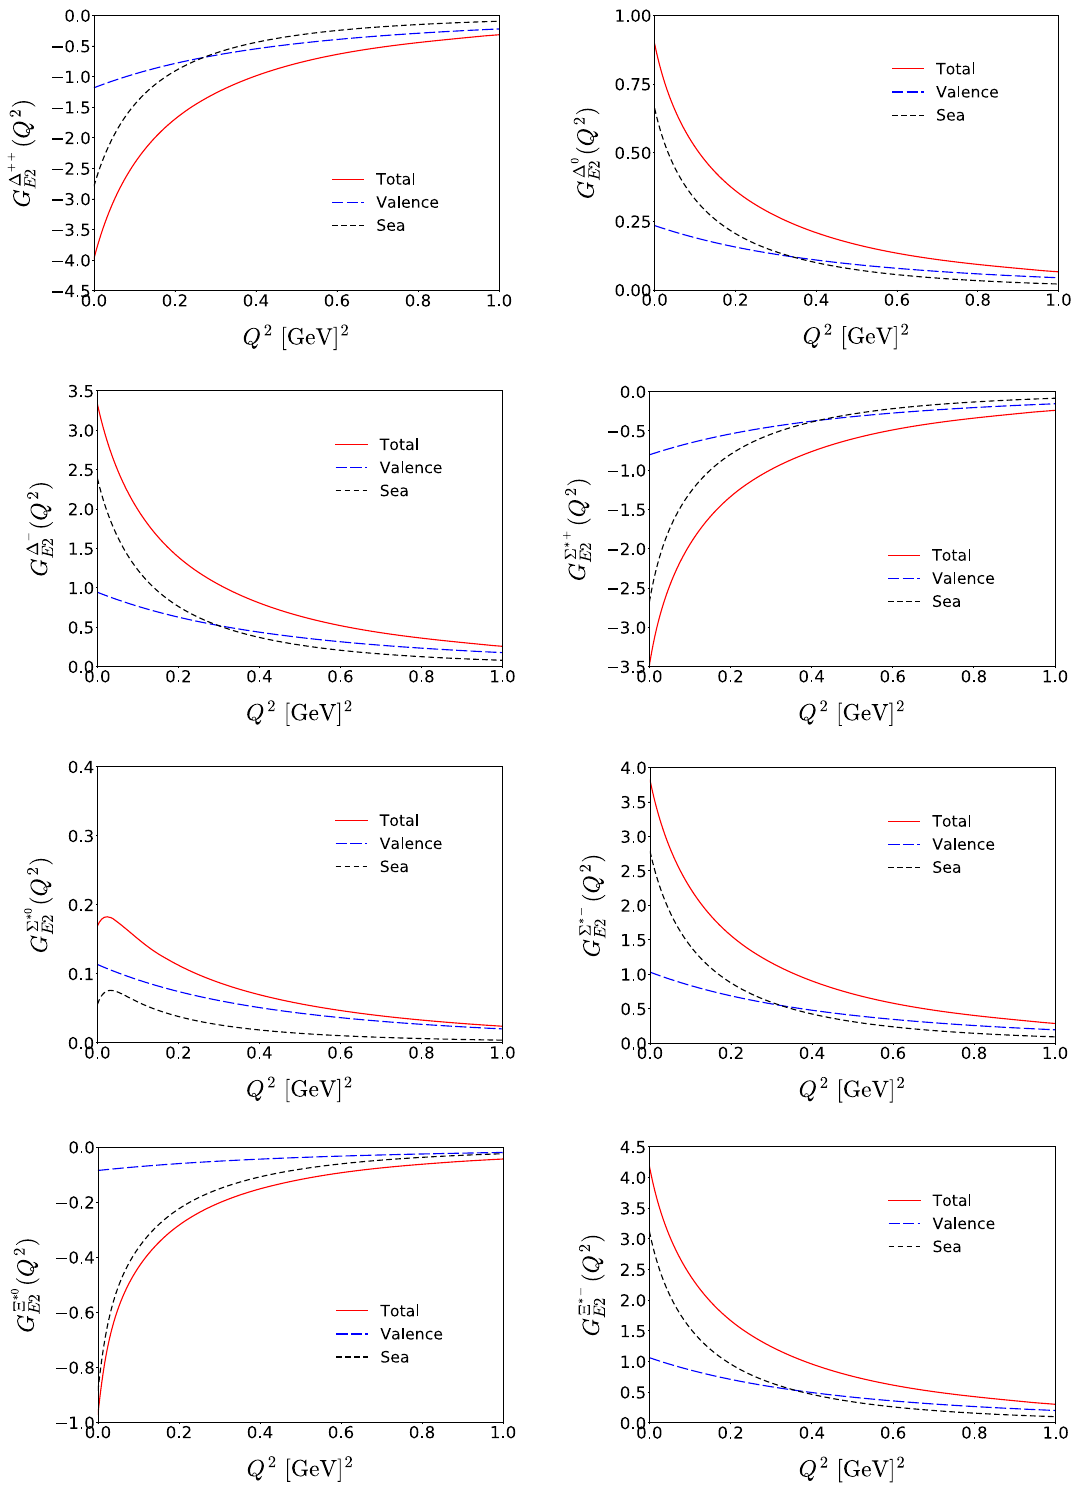
Fig. 6 Contributions of the valence and sea quarks to the electric quadrupole form factors of the other members of the baryon decuplet except for the (cid:2) + and (cid:5) − baryons. Notations are the same as in Fig.